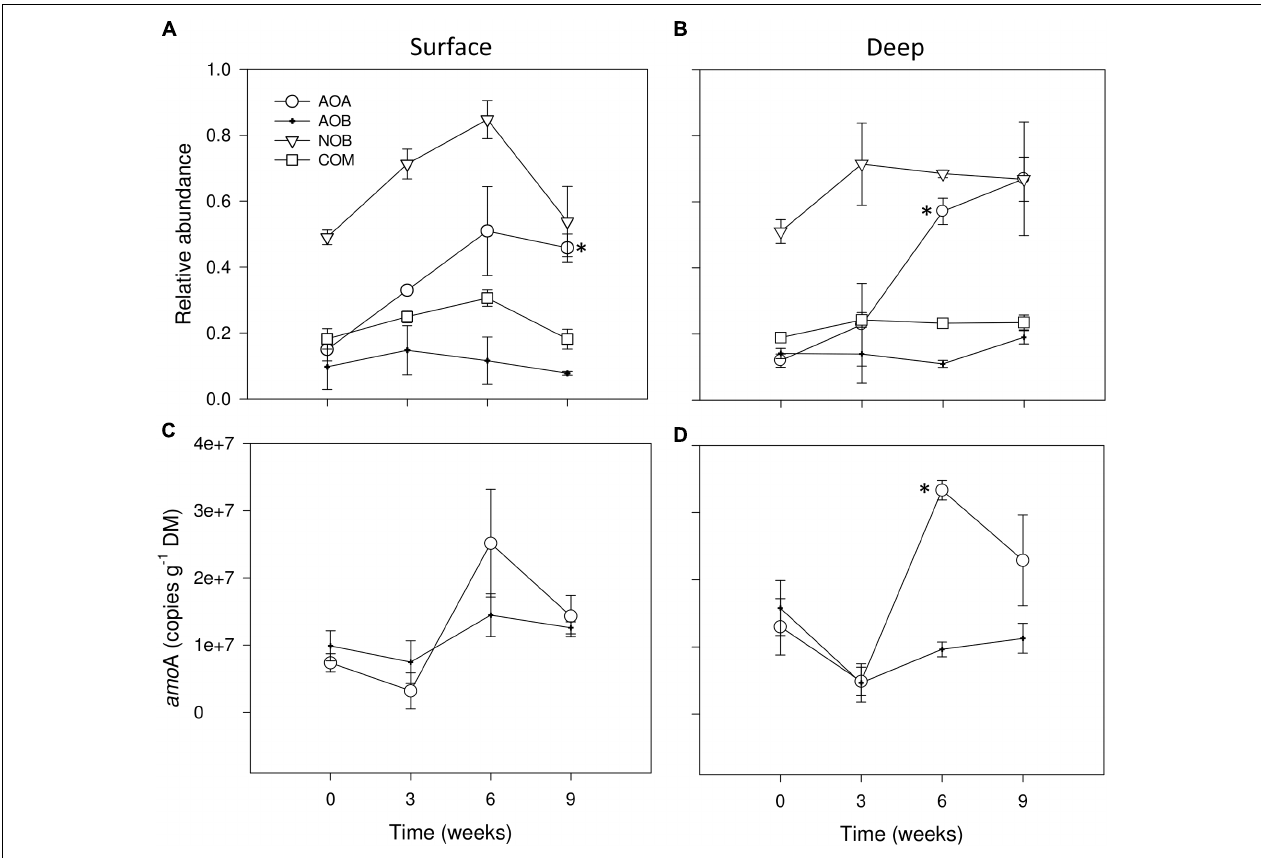
FIGURE 4 | Relative abundances (%) of 16S rRNA sequence tags from AOA, AOB, NOB and COMAMMOX groups in surface (A) and deep sediments (B) during initial conditions (i.e., 0 weeks) and after the different DPDs with no rainfall (i.e., 0 mm selected). Number of copies of amoA genes for AOA and AOB in surface (C) and deep sediments (D) during initial conditions and after the different DPDs with no rainfall. Asterisks ( ∗ ) denote significant ( P ≤ 0.05) differences to initial wet conditions after Student’s t -test followed by Holm’s correction for multiple comparisons. Values are means ± SE ( n =